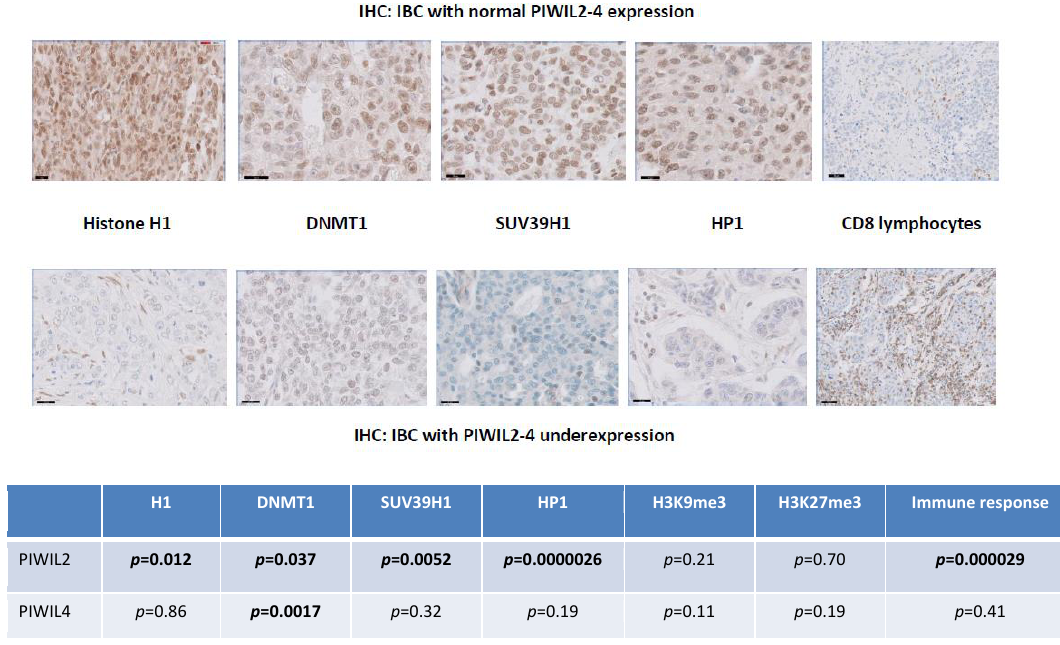
Figure 4. PIWIL2-4 underexpression is correlated with downregulation of H1, DNMT1, HP1 and SUV39H1 and upregulation of CD8 cytotoxic immune response. At magnification ×